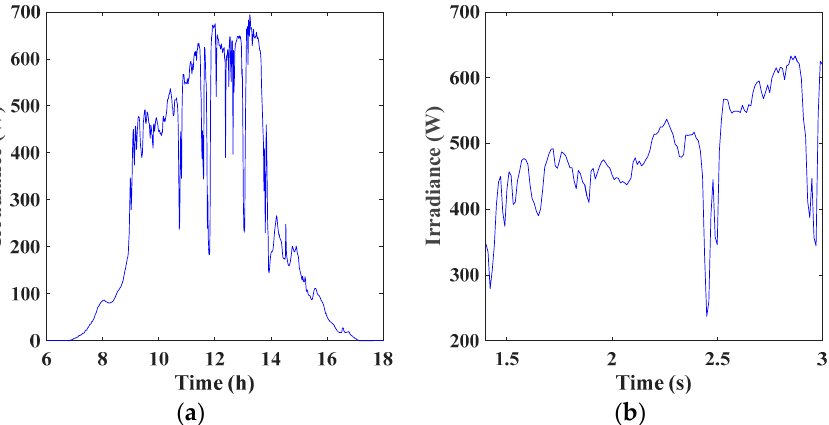
Figure 14. Measured solar irradiance during a cloudy weather day: ( a ) Whole day and ( b ) scaling down of solar irradiance to cope with simulation.